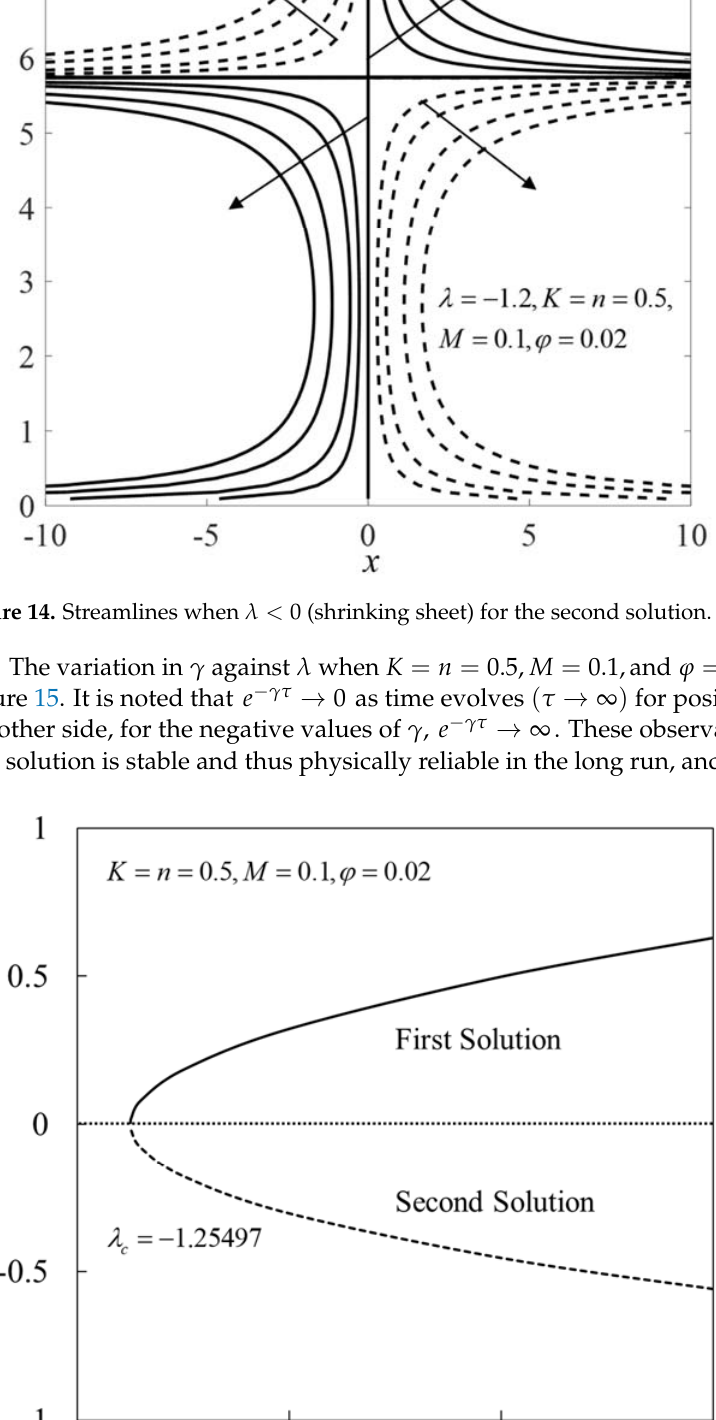
Figure 13. Streamlines when 𝜆 (cid:3407) 0 (shrinking sheet) for the first solution.